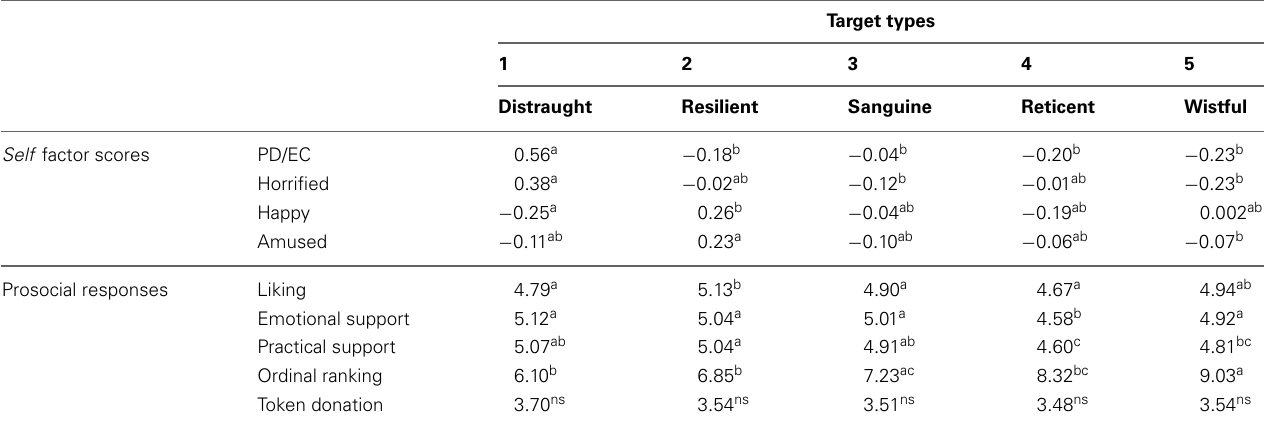
Table 2 | Mean emotion factor scores and ratings by target display type (Study